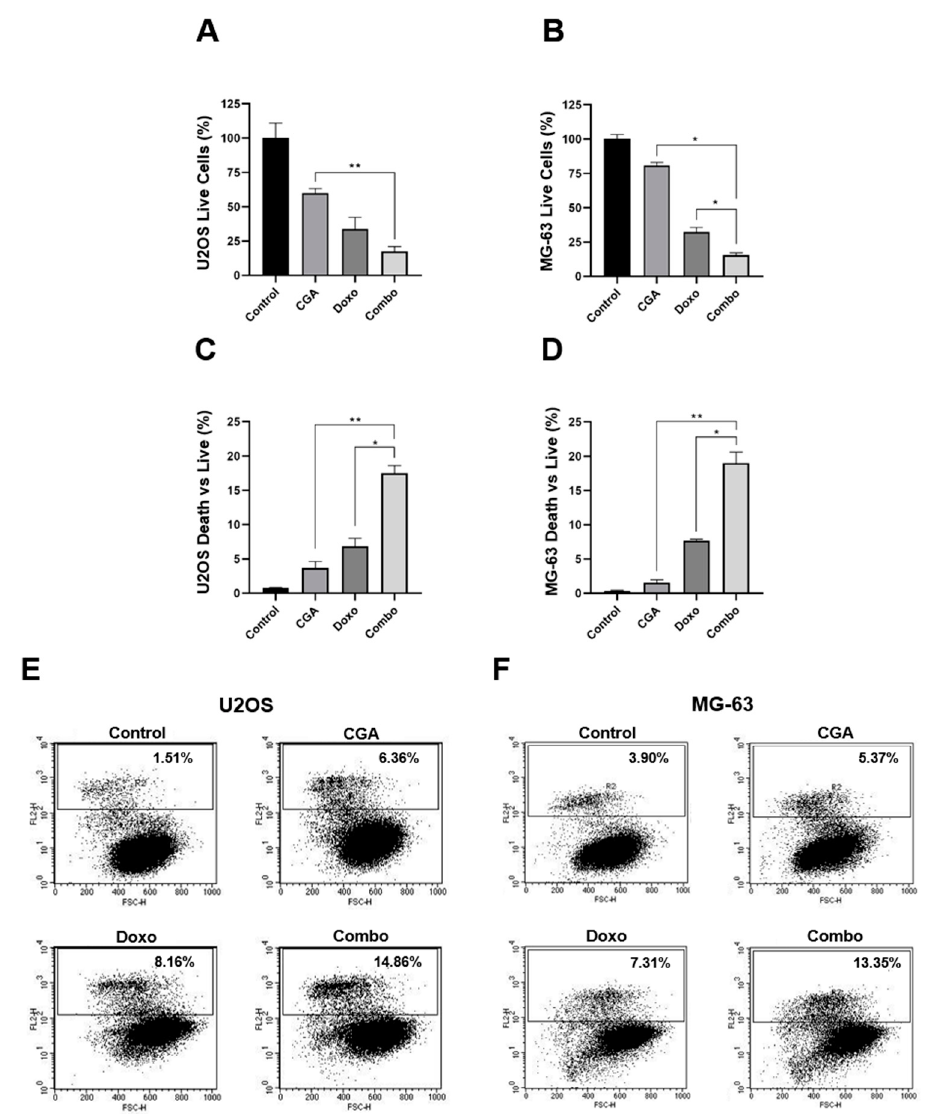
Figure 4. Investigation of CGA, Doxo, and CGA plus Doxo induced cell death in OS cells. U2OS and MG-63 were treated and not (control) with 200 µM CGA, 0.1 µM Doxo, and CGA plus Doxo (combo) for 48 h. Subsequently, living and dead cells were discriminated either by Trypan Blue ( A – D ) or by PI assay ( E , F ). Representative experimental dot-plots are shown in figure. Living cell number, as well as dead vs. live ratio, is expressed in percentage as mean ± SD. * p < 0.05, ** p < 0.01 by an unpaired two-tailed t -test. Experiments shown in the figure were repeated four times.